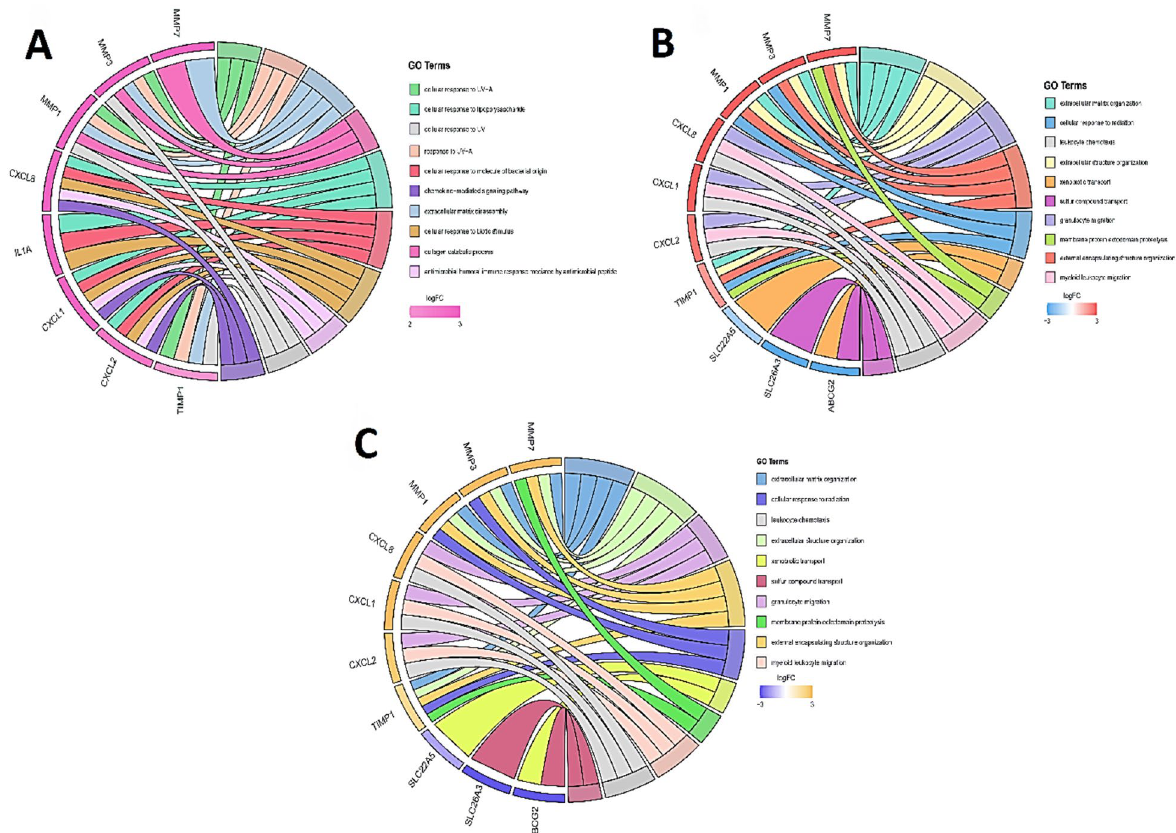
Figure 8. Gene Ontology (GO) cluster diagram showing the chord dendrogram of hub genes expression spectrum clustering. ( A ) Hub genes expression spectrum clustering based on biological process (BP). ( B ) based on the cellular component (Cellular Component: CC). ( C ) based on molecular function (Molecular Function: